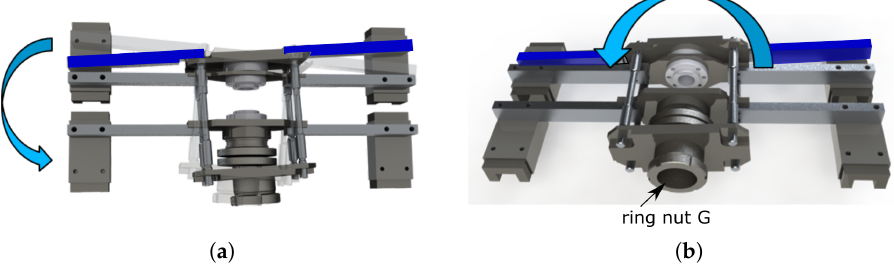
Figure 3. Enlargement of the mobile group. ( a ) Rotation allowed around the vertical axis. ( b ) Rotation allowed around the longitudinal